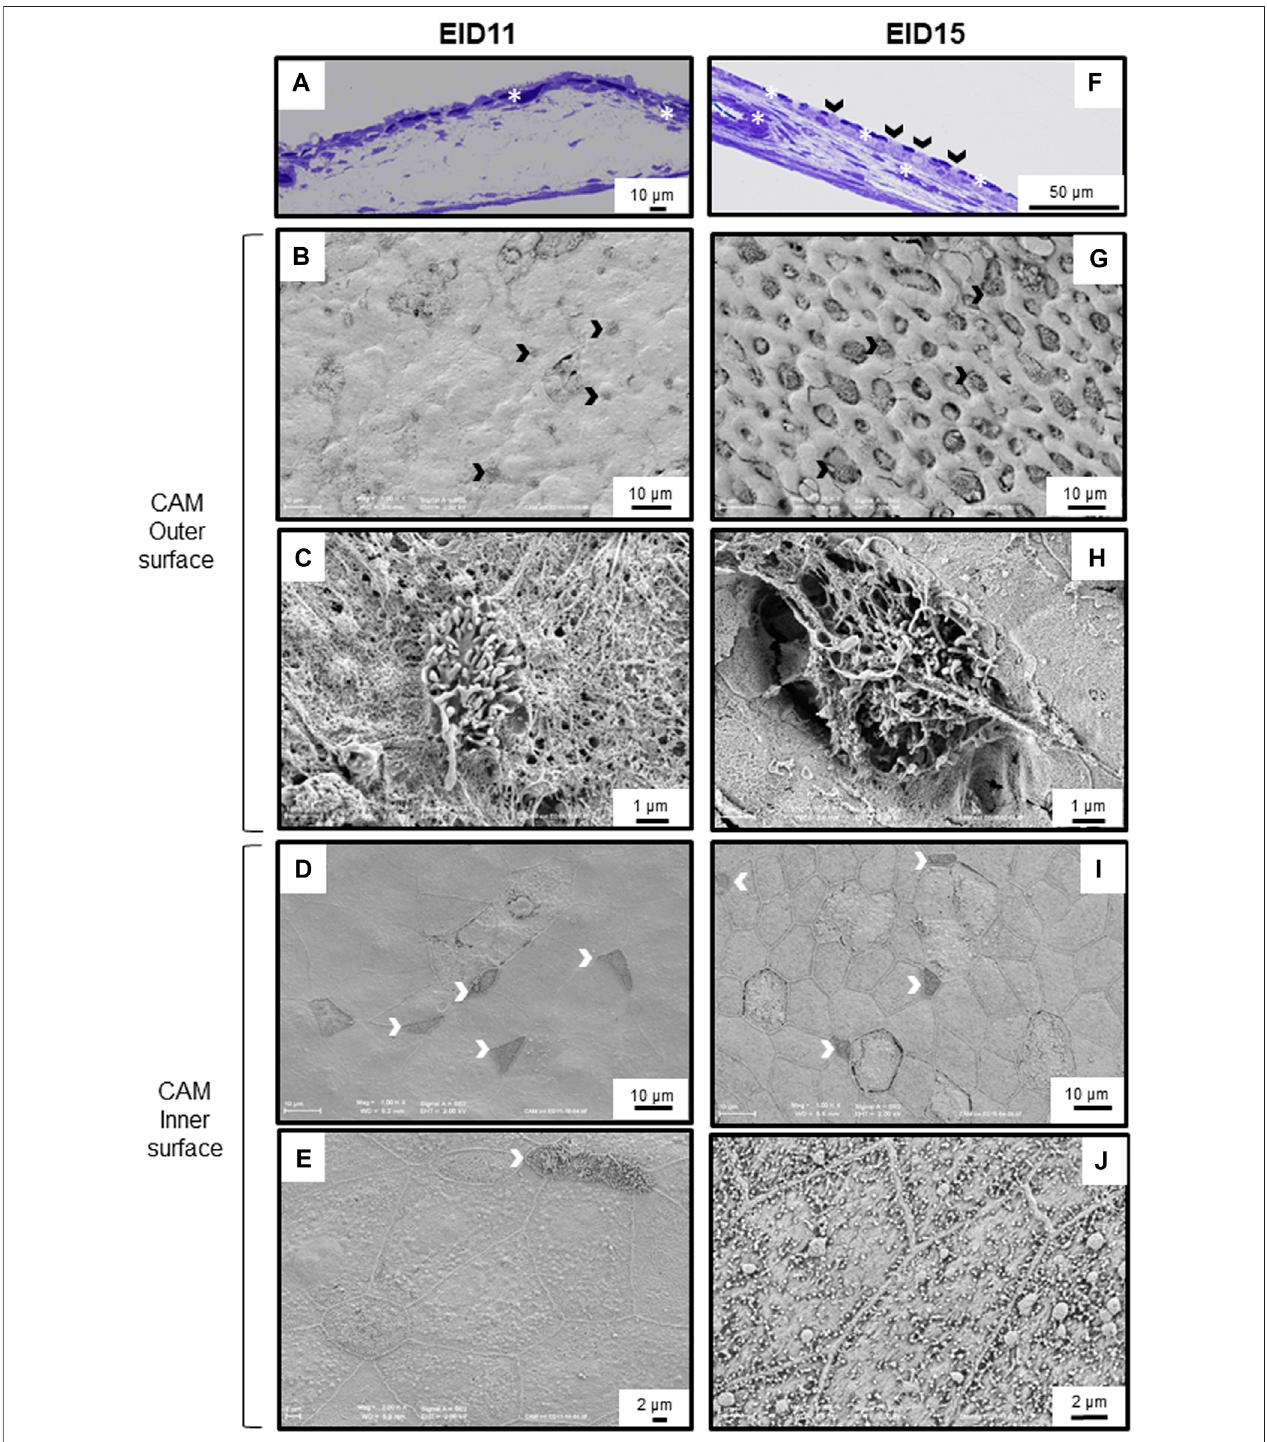
FIGURE4| Morphologicalmodi fi cationoftheCAMbetween11and 15 daysofincubation (EID11andEID15,respectively). (A – E) ,leftpanels,CAMmorphologyat EID11. (F – J) , right panels, CAM morphology at EID15. (A,F) , Toluidine Blue stained cross-section of the CAM. A large capillary is visible at EID15 [ (F) , white asterisk]. (B,G,C,H) , CAM outer surface (chorionic epithelium in contact with inner ESM). Black arrowheads in (A,F,B,G) correspond to some VC cells that characterize the chorionic epithelium. A higher magni fi cation of one of these VC cells is shown in (C,H) . (D,I,E,J) , CAM inner surface (allantoic epithelium in contact with allantoic fl uid). White arrowheads correspond to cells with fi lopodia. White asterisks indicate capillaries. An illustration of samplings is given in Figure 1 . Each micrograph is representative of fi ve independent samples ( n = fi ve eggs).